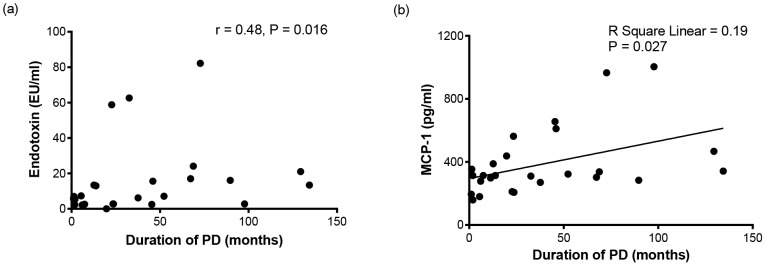
Correlations between the duration of peritoneal dialysis and serum endotoxin (a) and serum MCP-1 (b).A positive association between the duration of PD and serum endotoxin (a) and linear association between the duration of PD and serum monocyte chemoattractant protein-1 (b) levels in patients on CAPD.